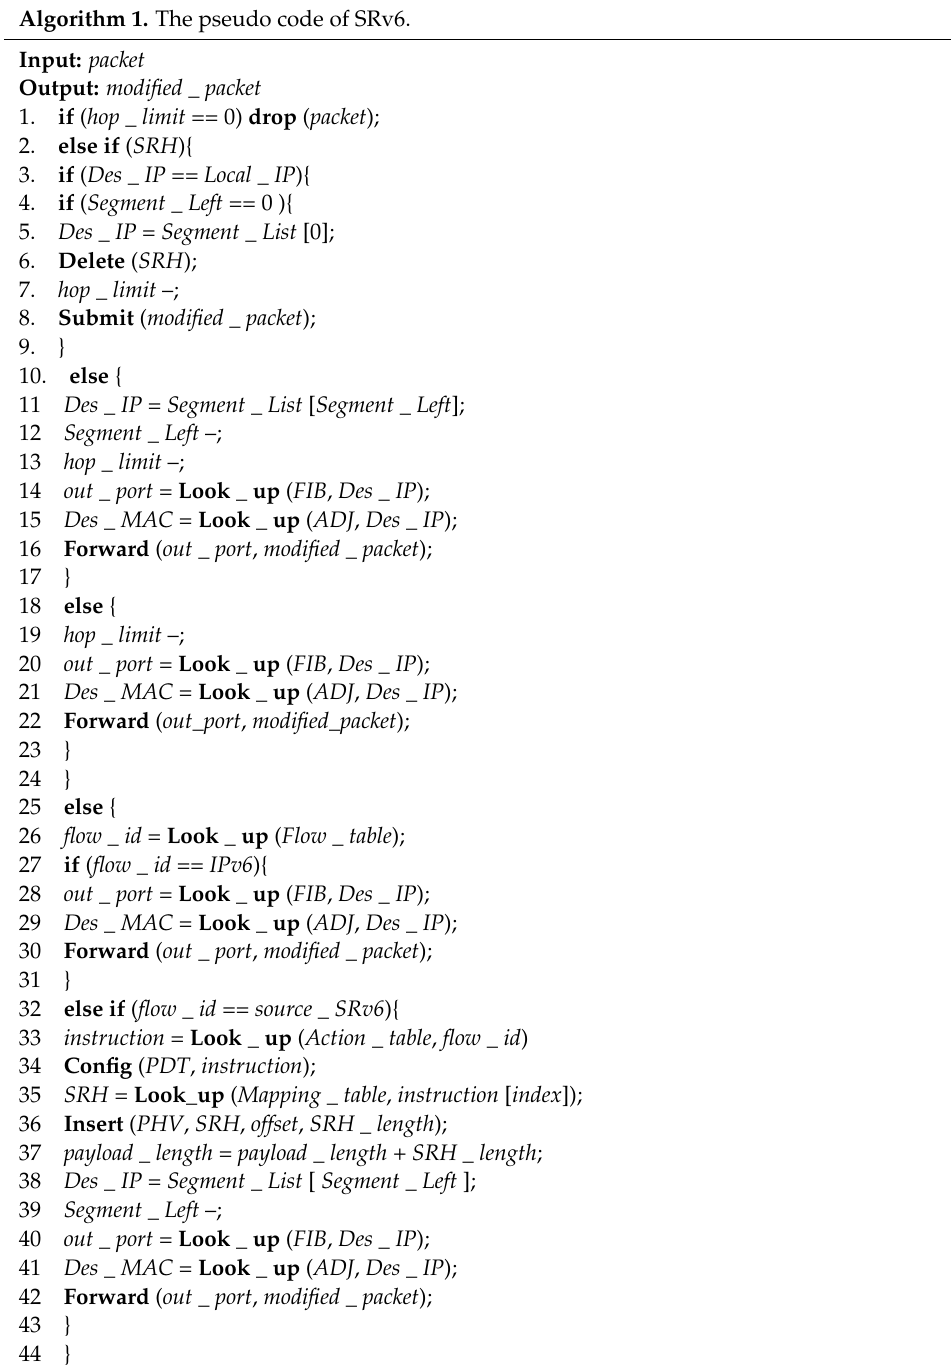
Algorithm 1. The pseudo code of